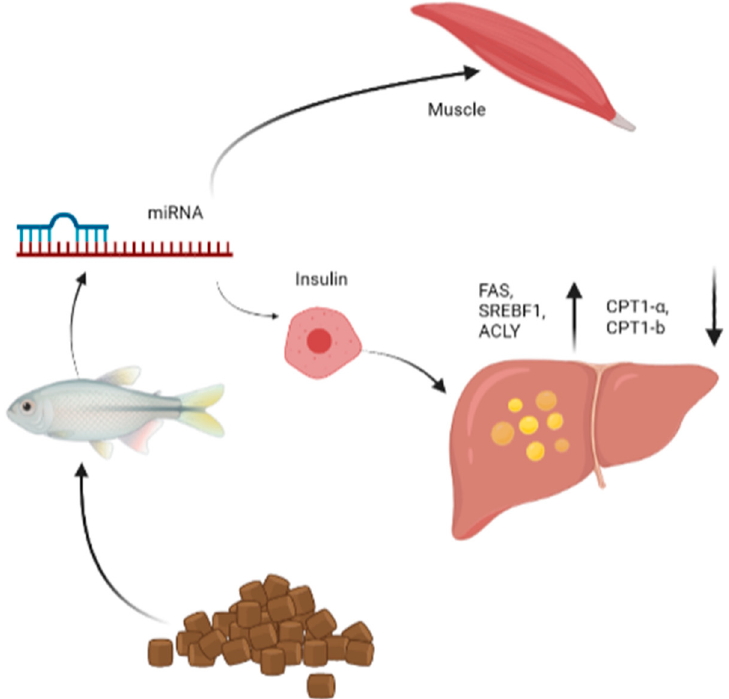
Figure 4. Role of microRNAs in the regulation of insulin and liver metabolism including the upregu- lation of FAS, SREBF1, ACLY and downregulation of CPT1a, CPT1b. FAS, SREBF1, ACLY, CPT1a and CPT1b, etc., are regulated by miRNAs under feed in fish. FAS, mean Fatty acid synthase; SREBF1, sterol regulatory element binding transcription factor 1; ACLY, mean ATP citrate lyase; CPT1a, mean carnitine palmitoyl-transferase 1a; CPT1b, mean carnitine palmitoyl-transferase 1B.